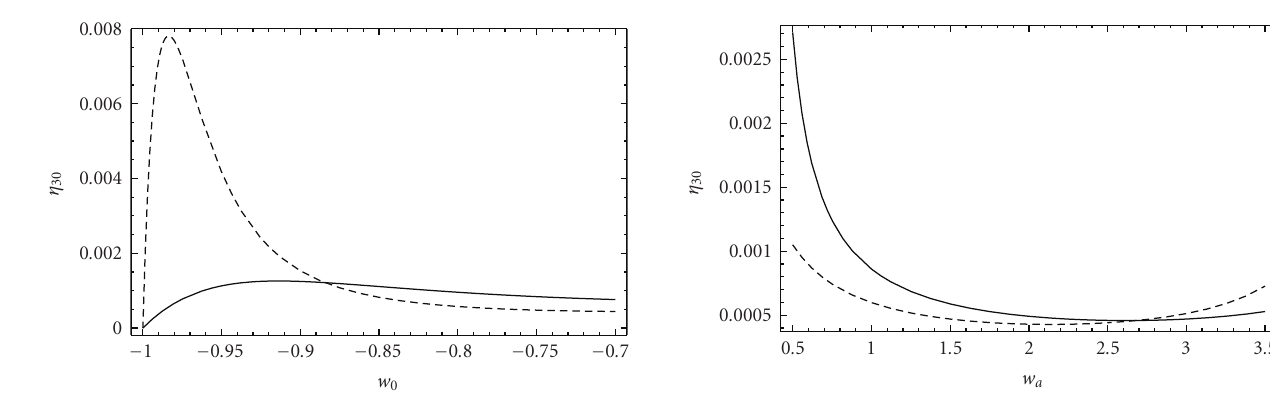
Figure 4: The dimensionless ratio between the present day values of f (cid:7)(cid:7)(cid:7) ( R ) and f ( R ) as function of the w a parameter for models with w 0 = − 1. Short dashed and solid lines refer to models with Ω M = 0 . 041 and 0 . 250,